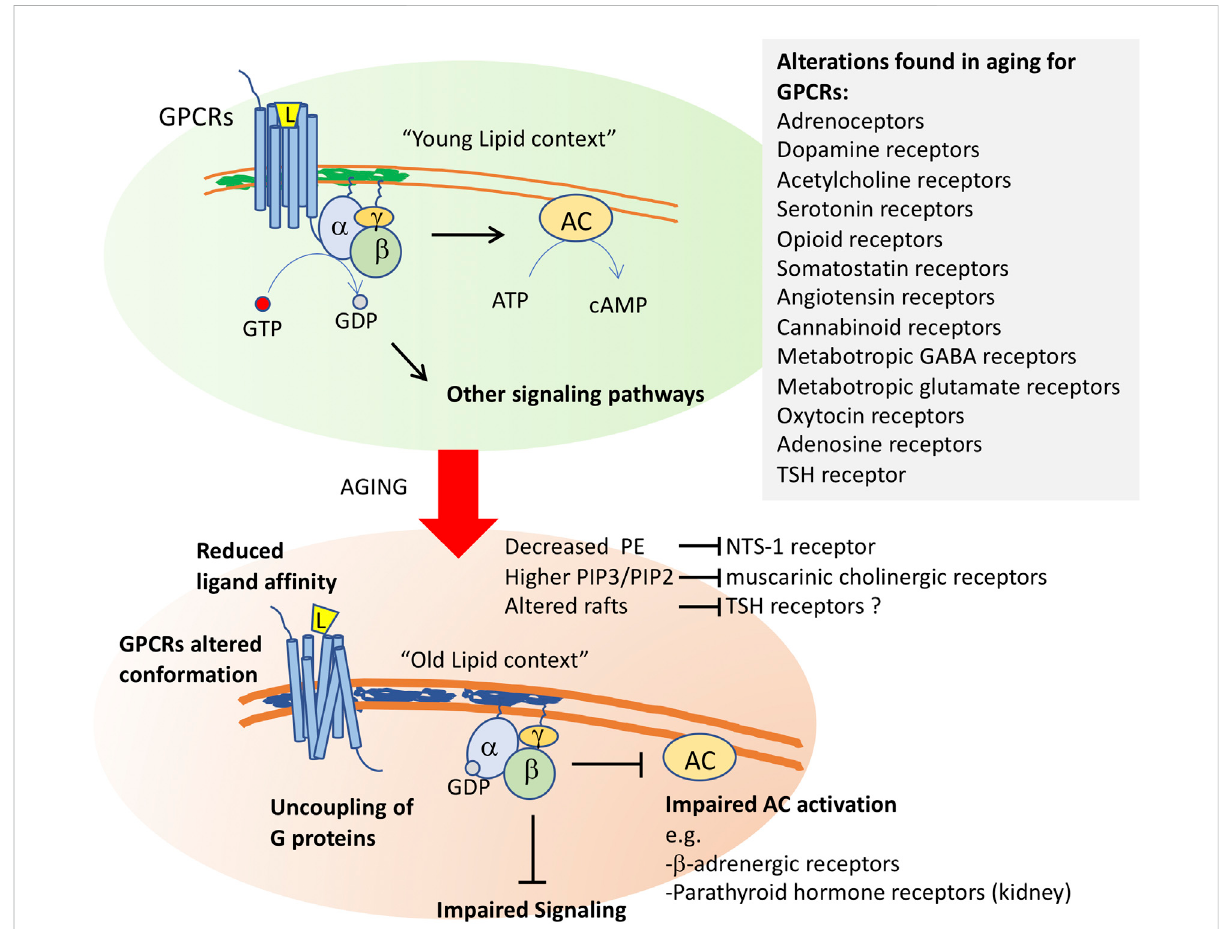
FIGURE 2 Membrane aging leads to G protein-coupled receptor dysfunction. After ligand (L) binding, the G protein-coupled receptors transduce environmental signals by promoting a GTP-GDP exchange at the α -subunit of the coupled trimeric G protein. Activated G proteins then initiate signaling through several pathways, including the activation of adenylyl cyclase (AC). Changes in membrane properties in old cells impact GCPR function at several levels. It will alter the conformation of these receptors, whose quaternary structure is formed by 7-transmembrane segments. Altered function was shown for neurotensin receptor-1 (NTS-1) by decreased levels of phosphoethanolamine, for muscariniccholinergic receptorsbyalteredphosphoinositideratios,andithasbeenproposedforthyroidstimulatinghormonereceptor,whoseproperactivityoccursinraft fractions of the plasma membrane. Altered membrane composition uncouples G proteins from their receptors, impairing downstream signaling. Impaired AC activation in aging membranes was shown for b-adrenergic receptors and for parathyroid hormone receptors in kidney. Alterations in the function of a high number of GPCRs (listed in the inset) have been shown in old cells in several